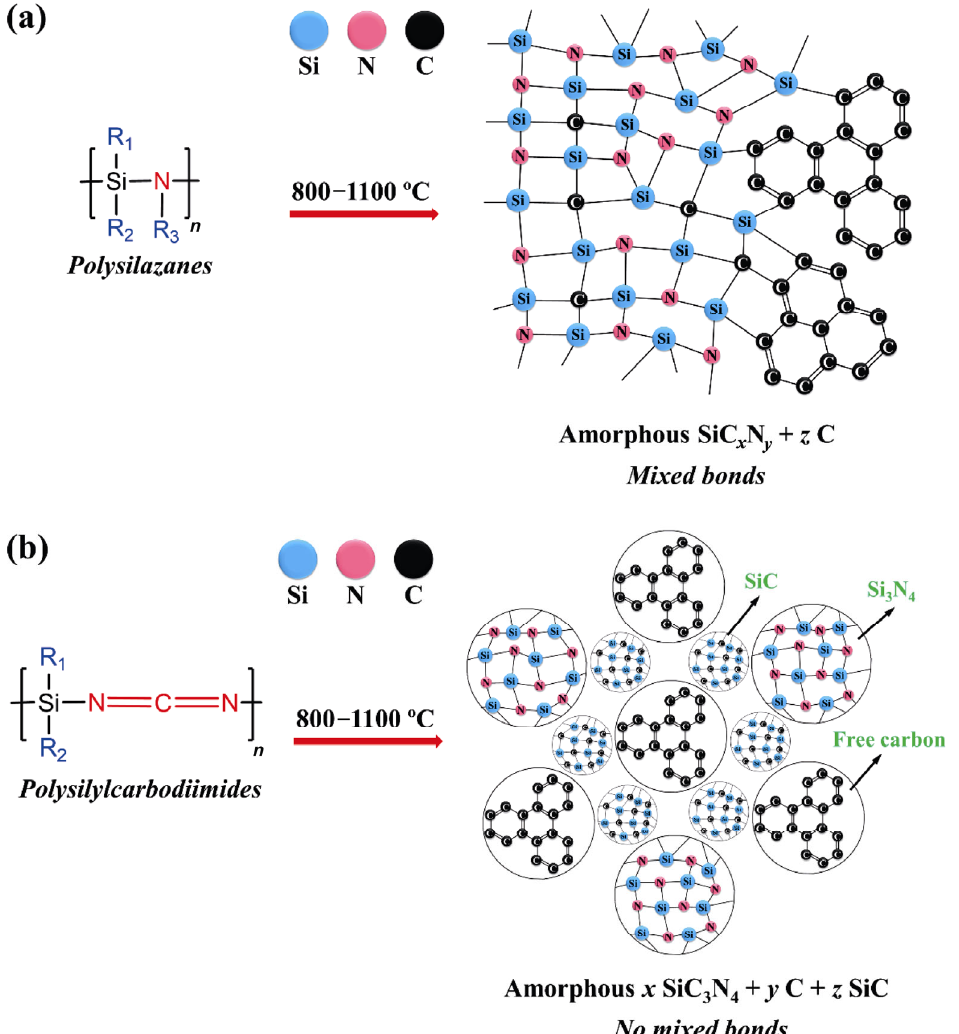
Fig. 4 Microstructure of amorphous SiCN ceramics derived from two different polymers: (a) polysilazanes, (b) polysilylcarbodiimides. Reproduced with permission from Ref. [36], © Elsevier Ltd. 2019.